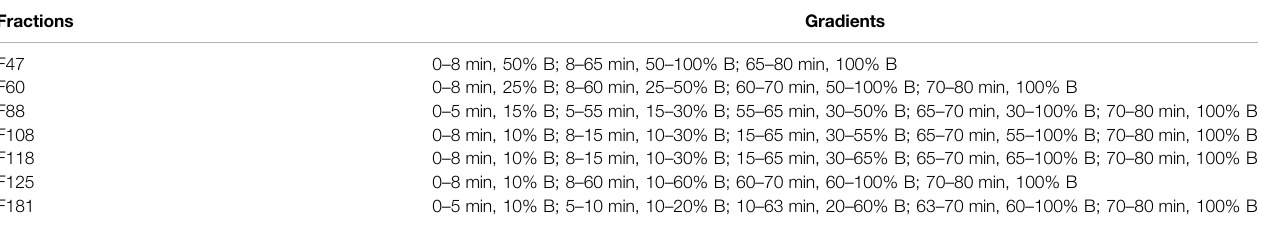
TABLE 1 | The HPLC gradient conditions of the selected